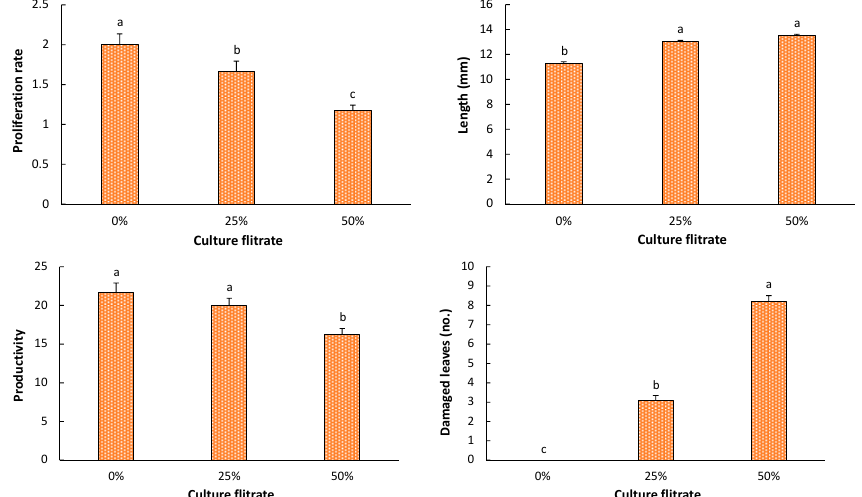
Figure 1. Proliferation rate, elongation, productivity, and number of damaged leaves in shoots of the mandarin cv. ‘Fortune’ exposed to different percentages of culture filtrate of Alternaria alternata . Data represent average ± SD values. Bars with different lower-case letters indicate a significant difference according to the LSD test ( p ≤ 0.05).